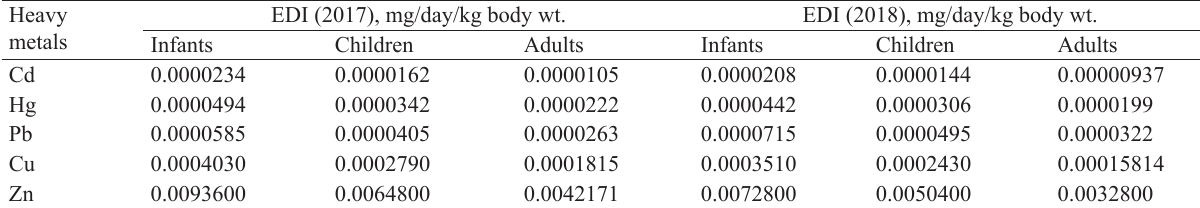
Table 2 Estimated daily intakes (EDI) of elements in edible tissues of Mullus barbatus L. from the southern Black Sea